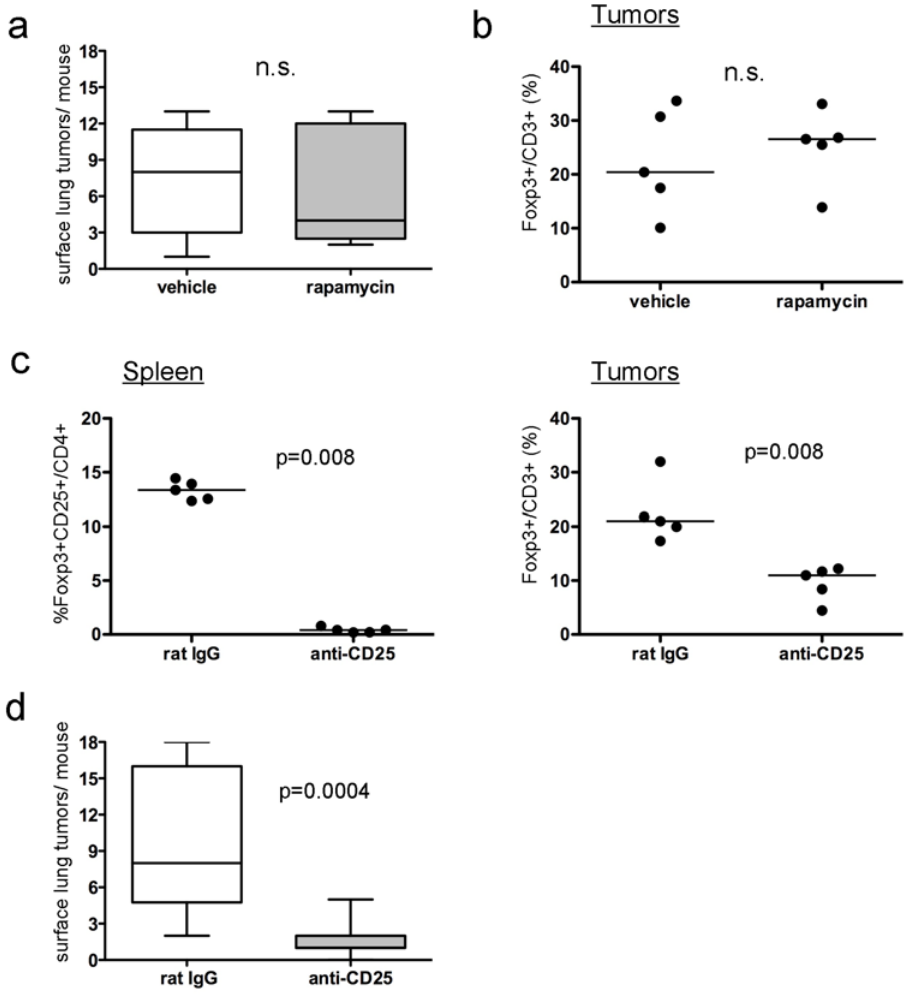
Figure 3. Depletion of Foxp3 + cells using an anti-CD25 antibody decreases the ability of rapamycin-resistant lung adenocarcinoma cells to form tumors. ( a–b ) Effect of rapamycin on IO33 tumor multiplicity (a) or tumor-associated percent of Foxp3 + /CD3 + cells (b). ( c ) Effect of rat IgG or anti-CD25 antibodies on the number of splenic Foxp3 + CD25 + /CD4 + cells (left) and IO33 tumor-associated %Foxp3 + /CD3 + cells (right). ( d ) Effect of anti-CD25 antibody or rat IgG on IO33 lung tumor multiplicity. For (a) and (d), boxes indicate interquartile range, lines indicate median, and whiskers indicate minimal and maximal values. For (b–c), each point represents a mouse and the line represents the median. n.s., not significant.